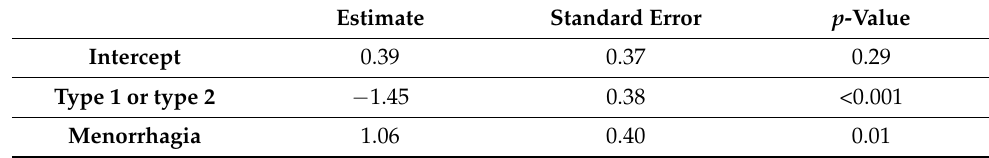
Table 6. Association among hemoglobin levels and study covariates. Estimate Standard Error Pr(>|t|) Intercept